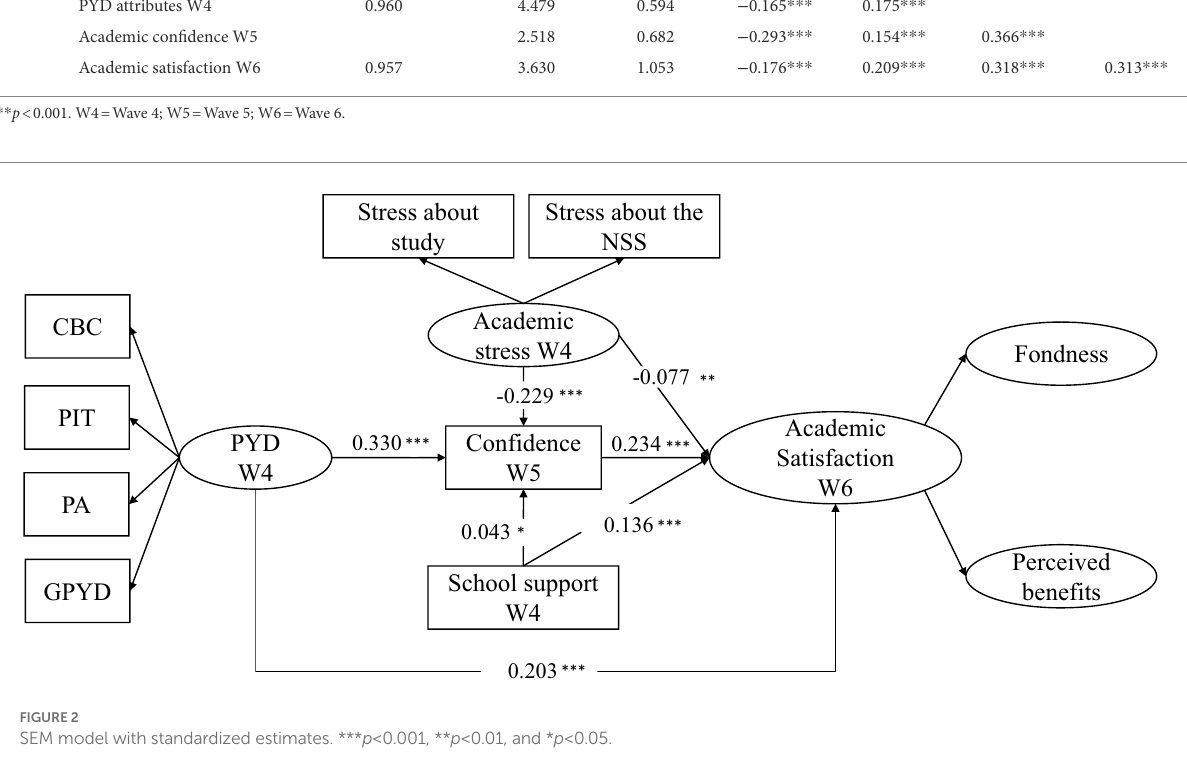
TABLE 2 Estimated predicting effects of academic factors, PYD attributes with the mediating effect of confidence in SEM.